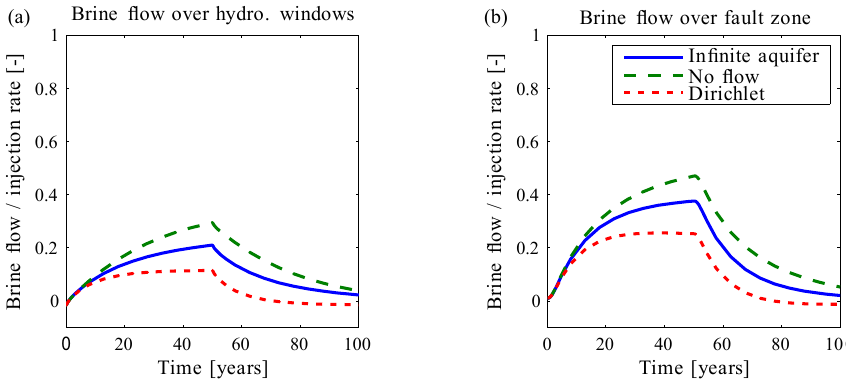
Figure 11. Scenario study 2: boundary conditions. Panel (a) shows brine flow over hydrogeological windows into the shallow aquifers (normalized by the injection rate). Panel (b) shows brine flow over fault zone into the shallow